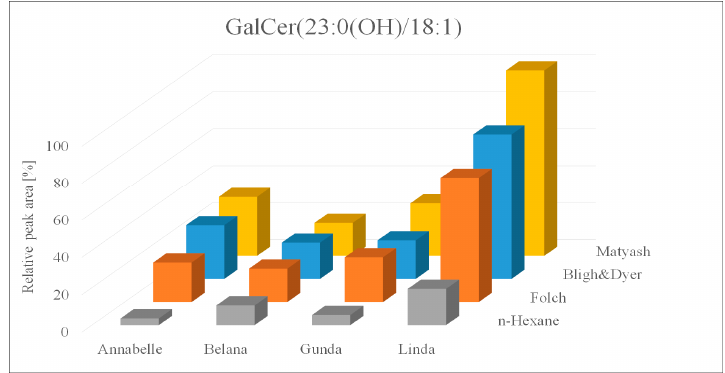
Figure 2. Relative peak areas of the galactocerebroside GalCer (23:0(OH)/18:1) across four extraction protocols and four different potato varieties.